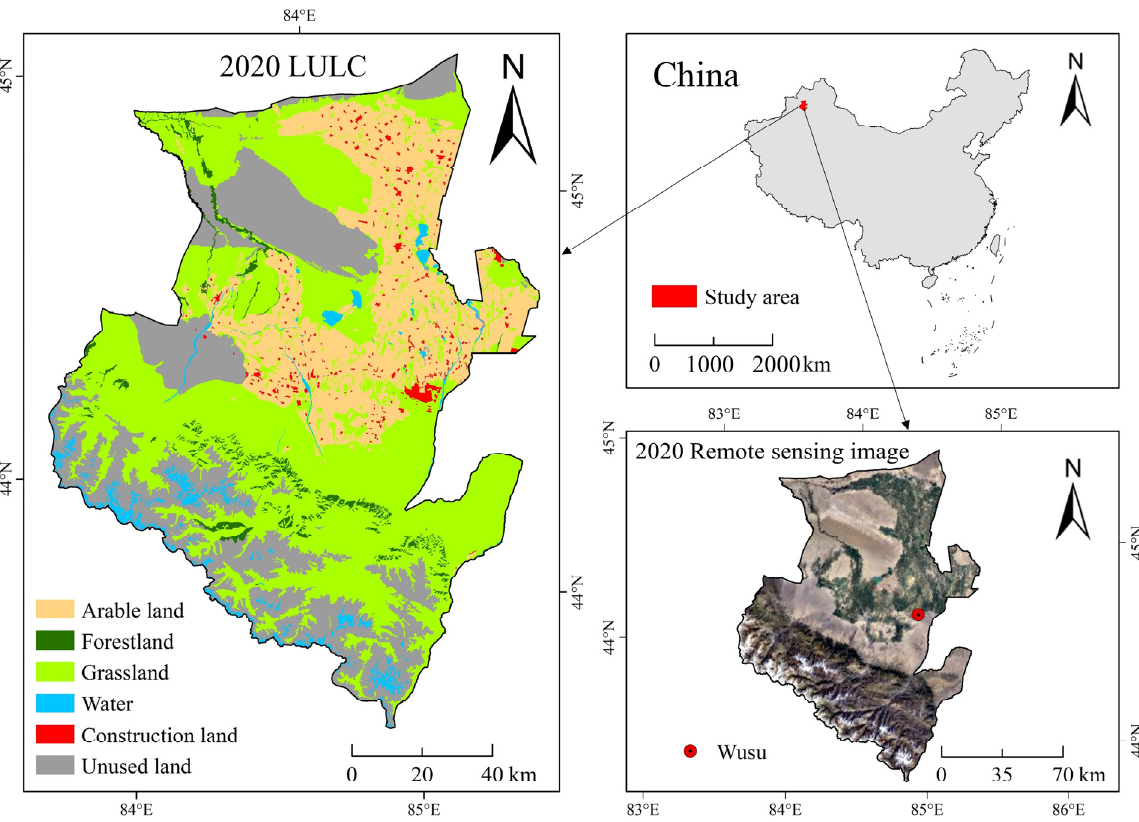
Figure 1. Geographical location of the study area in China and its distribution of LULC (the LULC data of 2020 are from the Resource and Environmental Science Data Center of the Chinese Academy of Sciences, and the remote sensing image of 2020 was taken by the Gaofen-2 resource satellite).